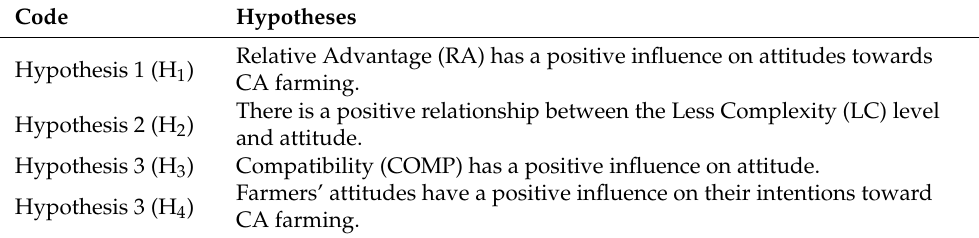
Table 2. Research